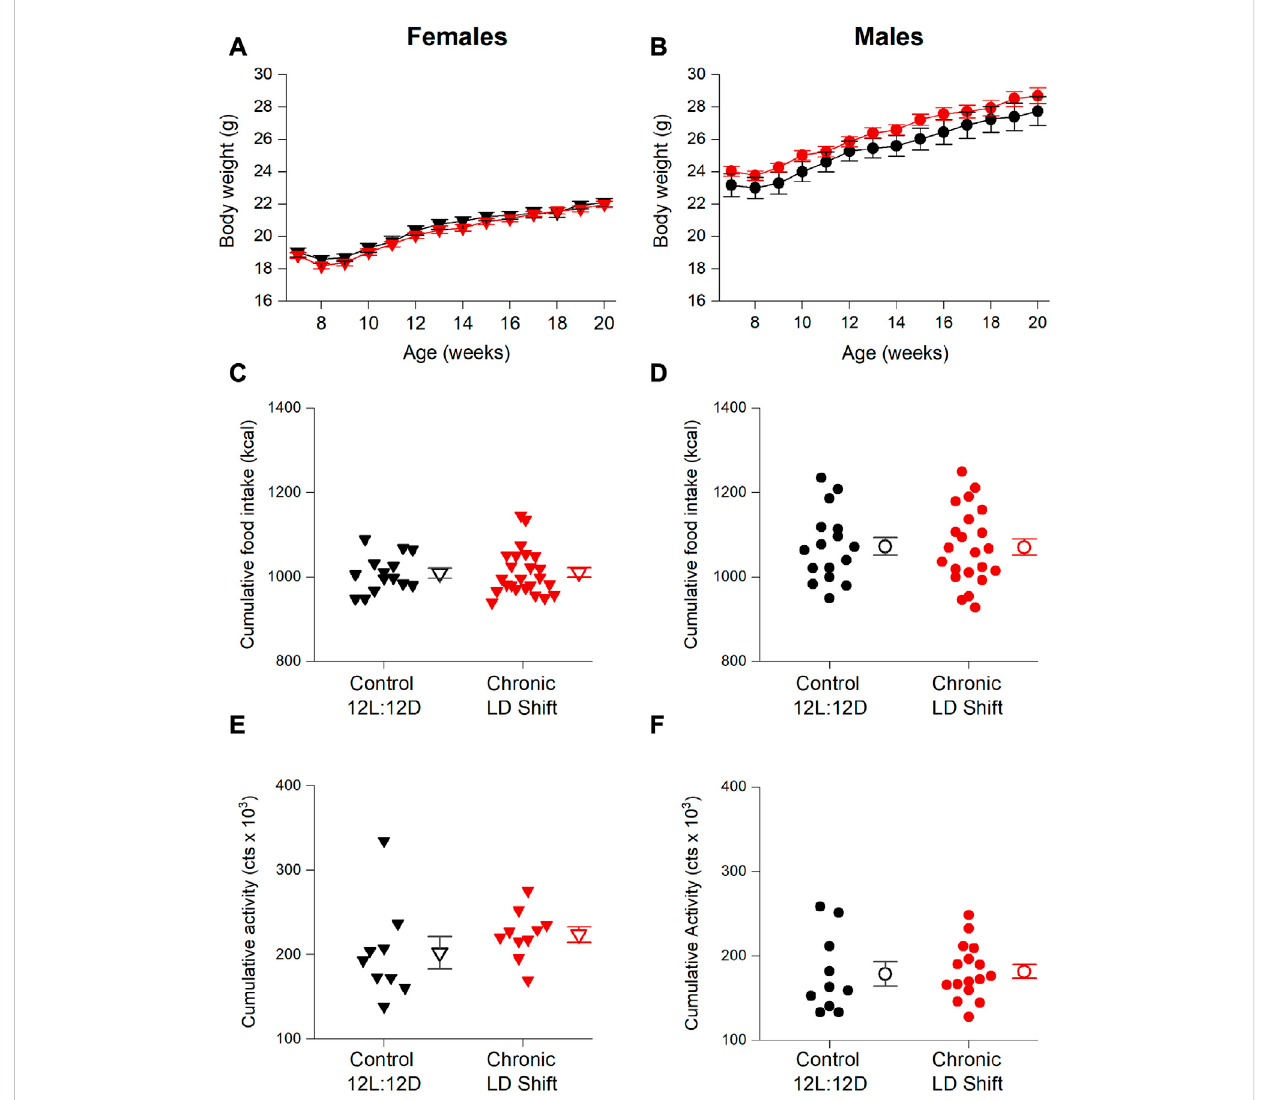
FIGURE 3 Chronic LD shifts did not alter energy balance in male and female ApoE − / − mice. Female (A,C,E) and male (B,D,F) ApoE − / − mice were maintained in control 12L:12D (black symbols)orchronicLDshifts(redsymbols)for12 weeks.Body weights (A,B) mean± SEM)weremeasured weekly,andcumulative food intake (C,D) and cumulative activity counts (E,F) were summed for the entire experiment. (C – F) : individual mice are closed symbols and open symbols are mean ±